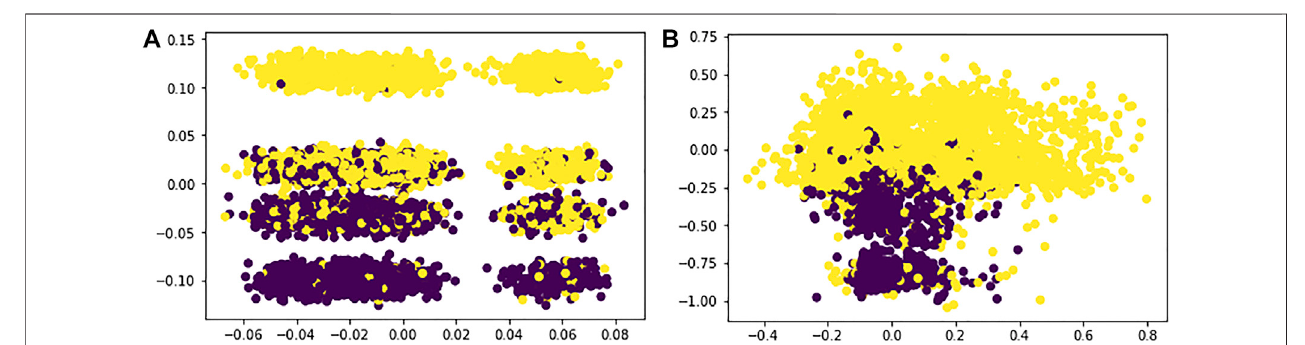
FIGURE 2 | (A) Lime spectral clustering; (B) Shap spectral